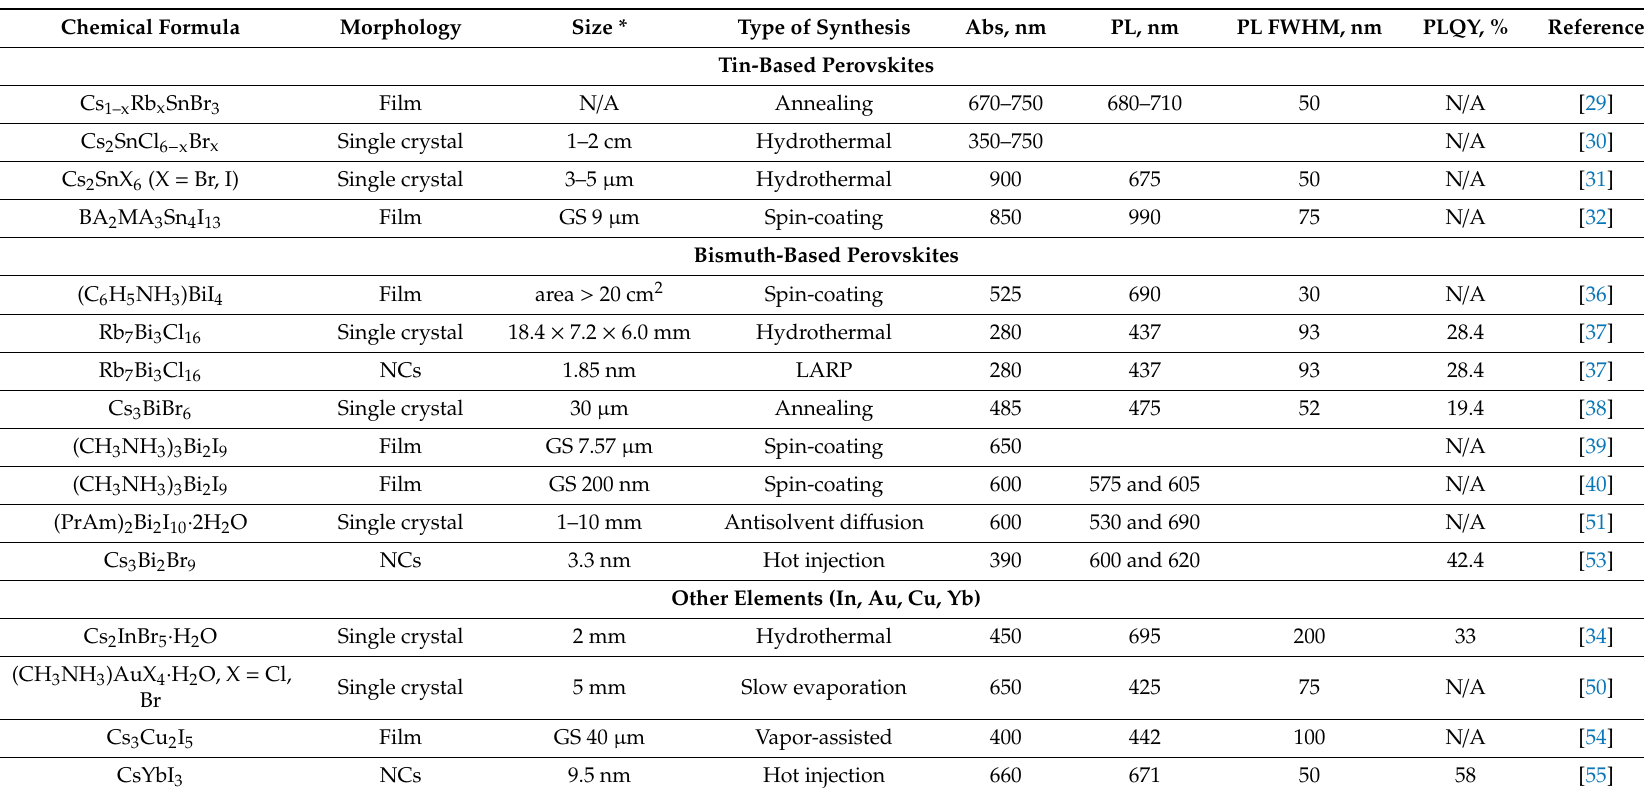
Table 1. Chemical formula, morphology, and optical properties of lead-free perovskite materials and their synthesis routes. Chemical